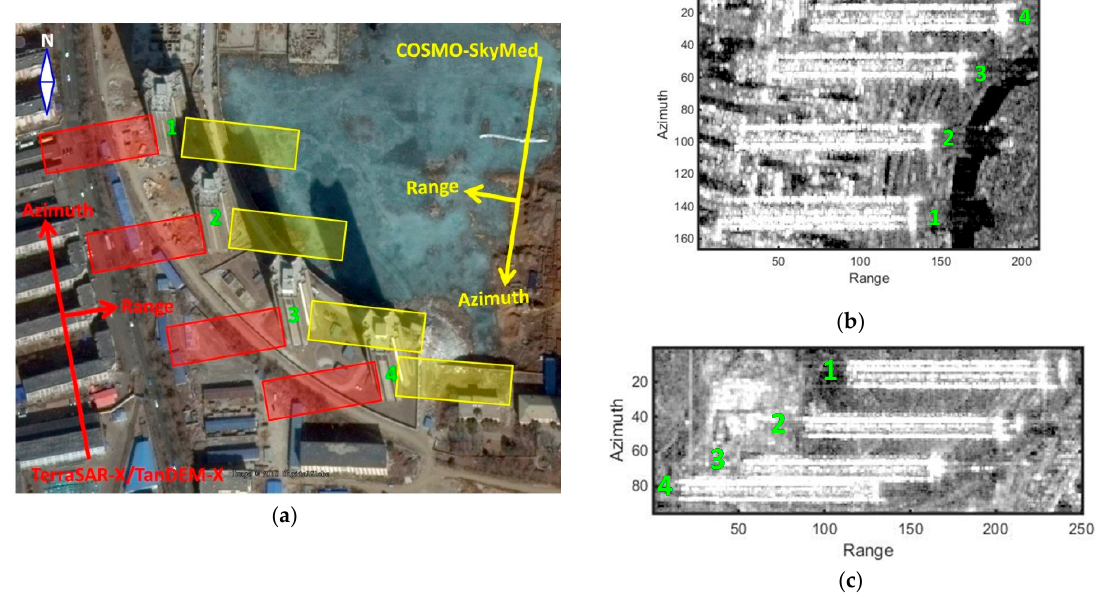
Figure 10. Remote sensing images of the Longzhimeng Changyuan study area: ( a ) Google Earth image; ( b ) average amplitude of the TerraSAR-X/TanDEM-X images; ( c ) average amplitude of the COSMO-SkyMed images.